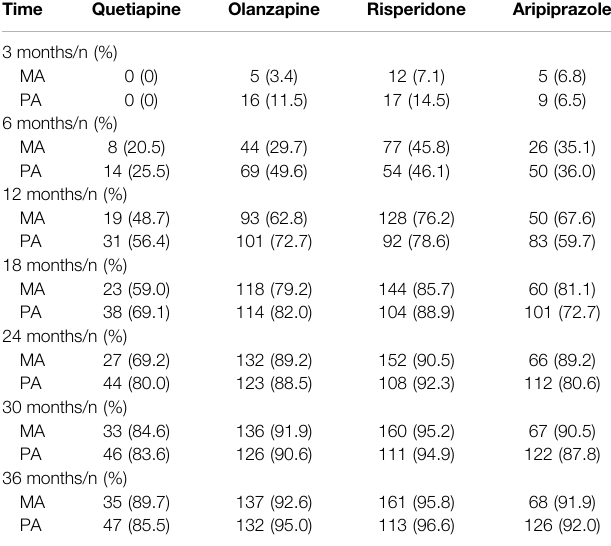
TABLE 4 | Treatment discontinuation at different time